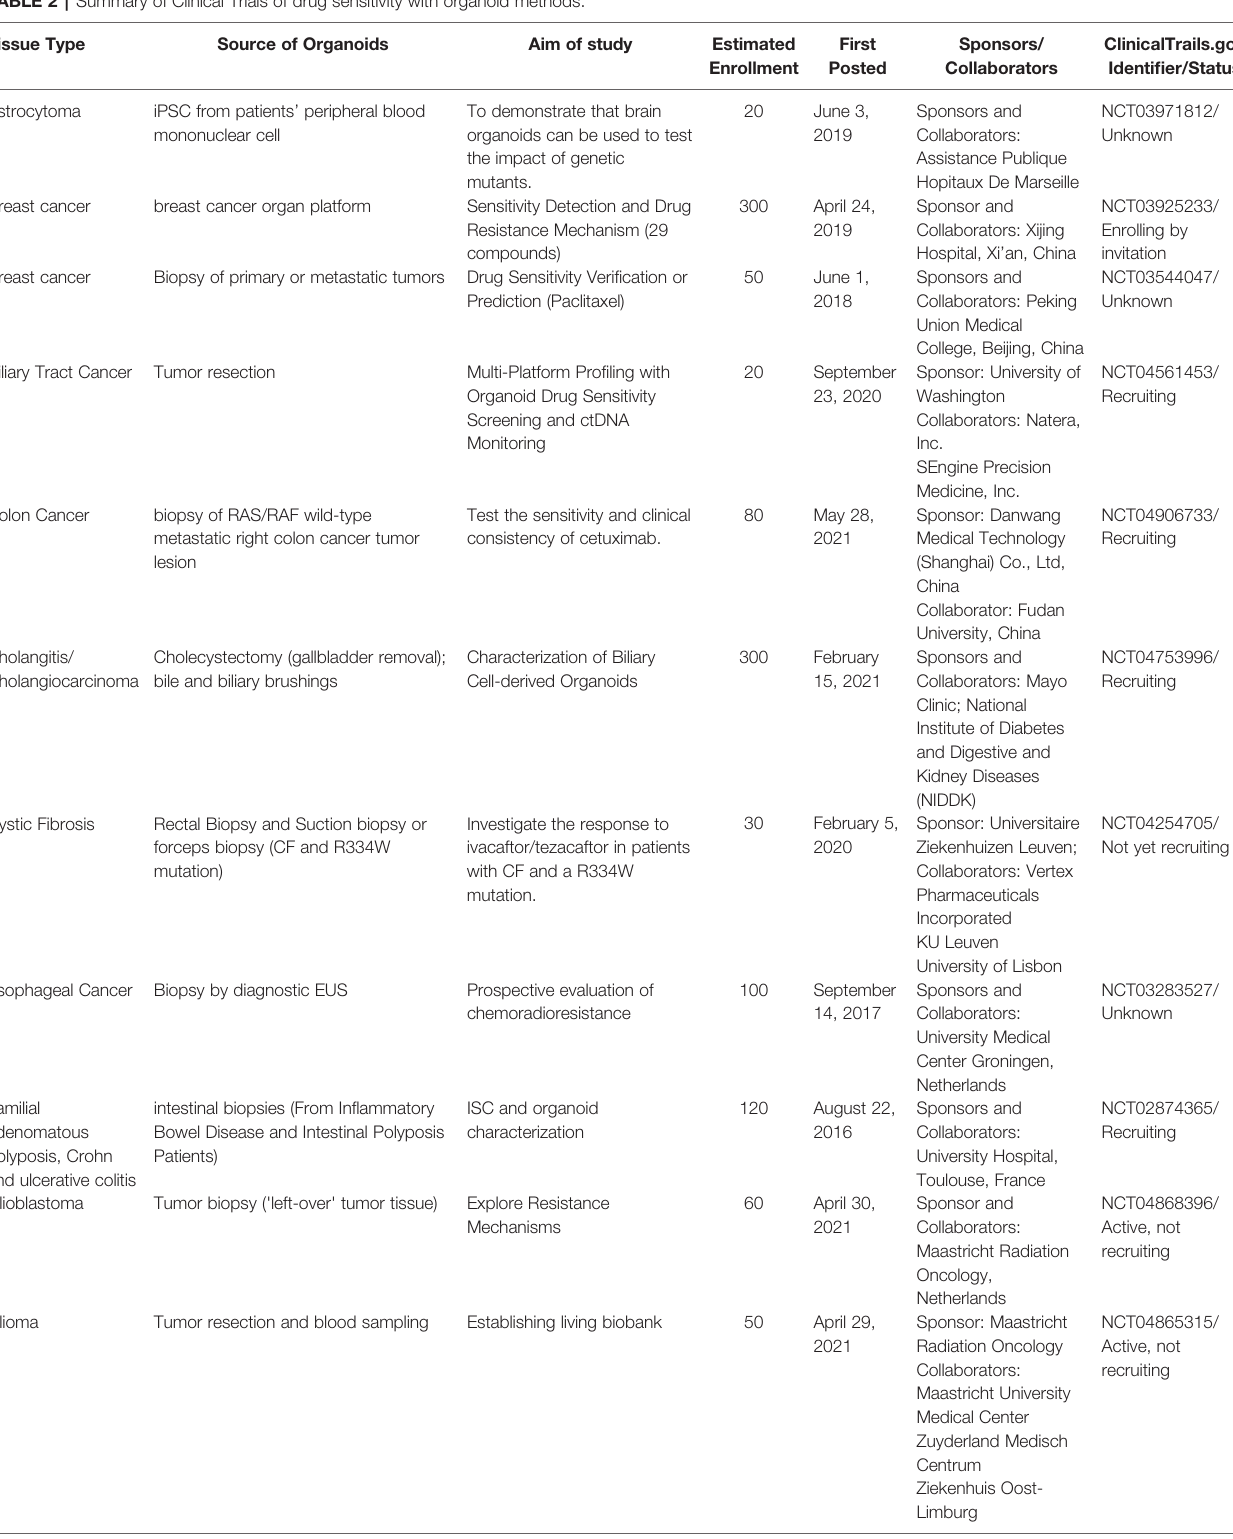
TABLE 2 | Summary of Clinical Trials of drug sensitivity with organoid